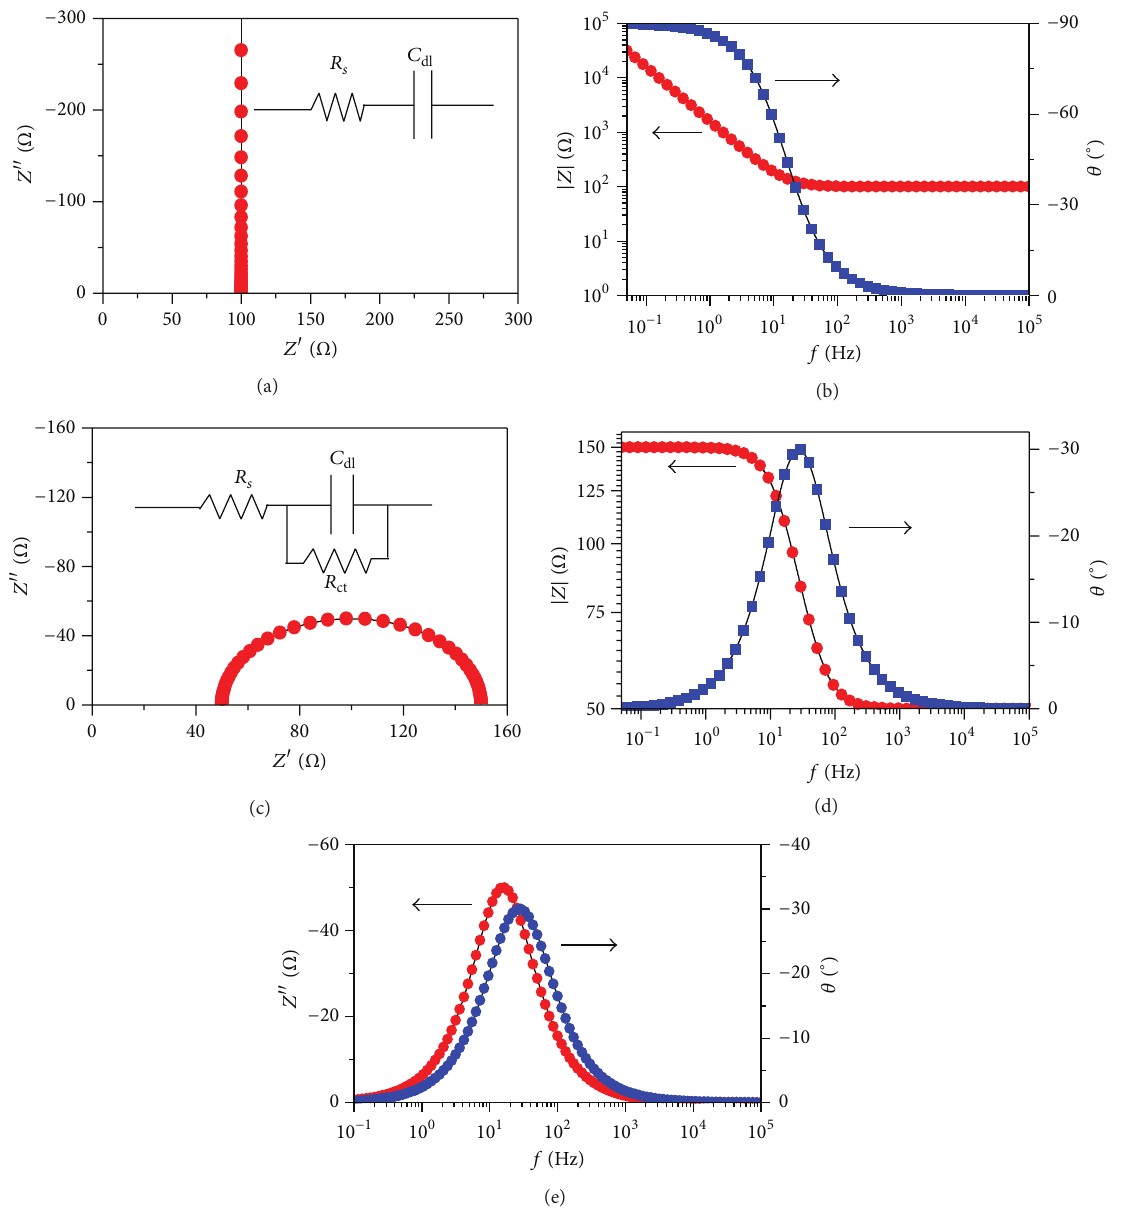
Figure 2: (a) Complex plane plot for the impedance corresponding to the equivalent circuit as shown in the inset with 𝑅 𝑠 = 50Ω and = 100 𝜇 F and (b) Bode magnitude and phase plot of the impedance. (c) Complex plane plot for the impedance corresponding to the 𝐶 dl = 100 Ω , and 𝐶 = 100 𝜇 F as shown in the inset; (d) Bode magnitude and phase; and (e) Bode simplified Randle’s circuit with 𝑅 𝑠 = 50 Ω , 𝑅 ct dl imaginary and phase plot of the